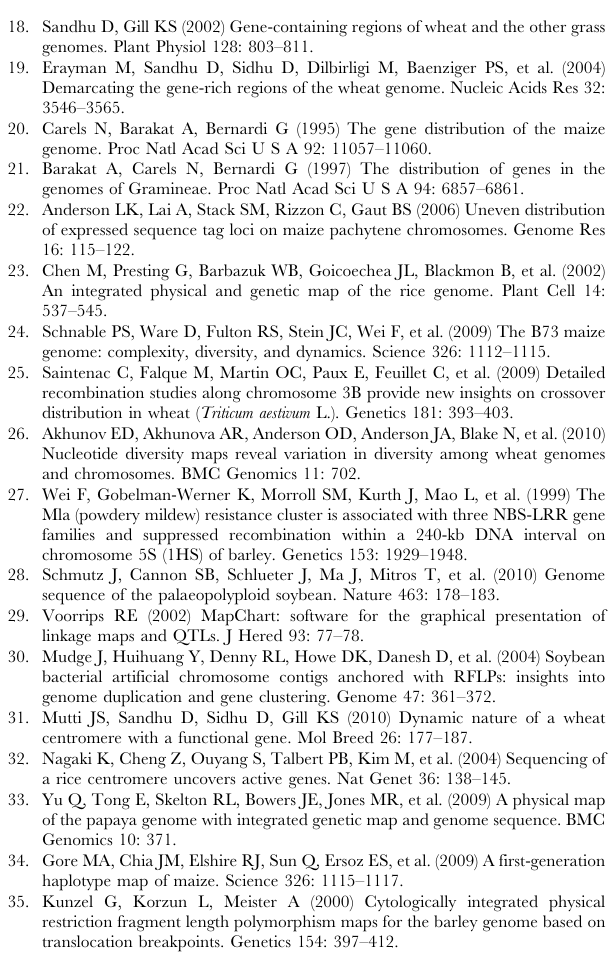
Figure S1 Comparison of integrated genetic linkage maps with sequence based physical maps for all soybean chromosomes. For creating the integrated linkage maps information was combined from three linkage maps [11,13,14]. For generating physical maps soybean sequence information was used (http://www.phytozome. net/soybean). Information about generation of integrated genetic maps and physical maps is presented in Materials/Methods section. The ‘‘MapChart’’ program was used to create maps of each chromosome